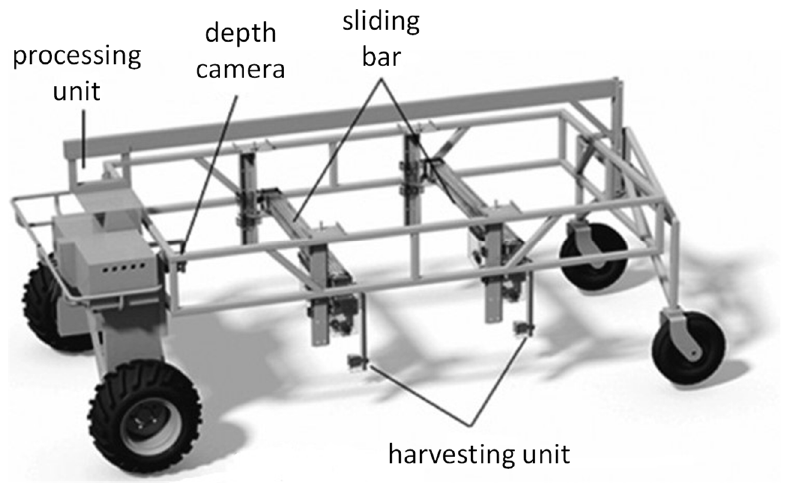
Figure 6. Illustration of the harvester.